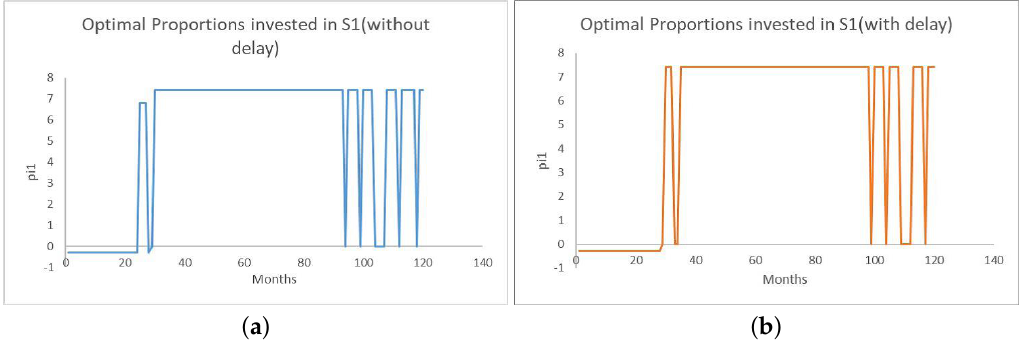
Figure 3. Simulated optimal proportions invested in S 1 for the cases without and with delay. Panels ( a ) and ( b ) for the optimal proportions invested in the ordinary share with and without time delay.